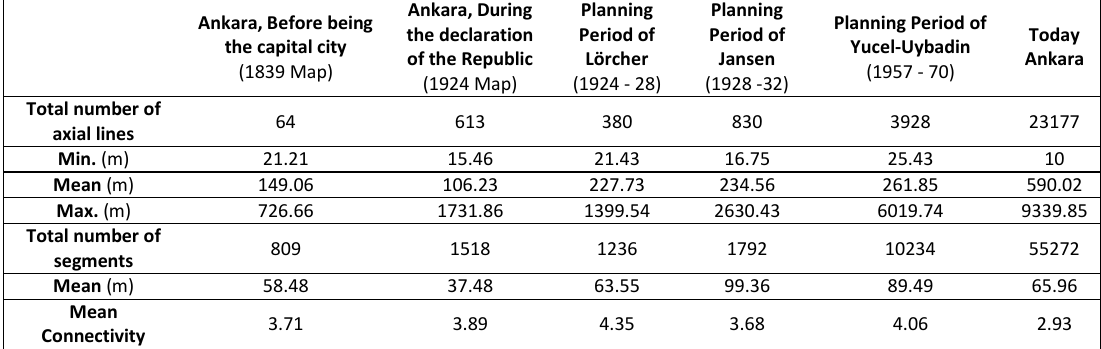
Table 1 Quantitative analysis of axis, segment and